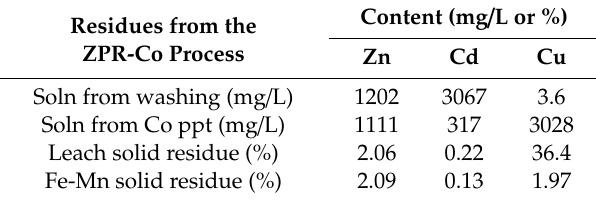
Figure 12. Liquid and solid residues generated by the ZPR-Co process. Table 12. Metal contents in the residues of the ZPR-Co